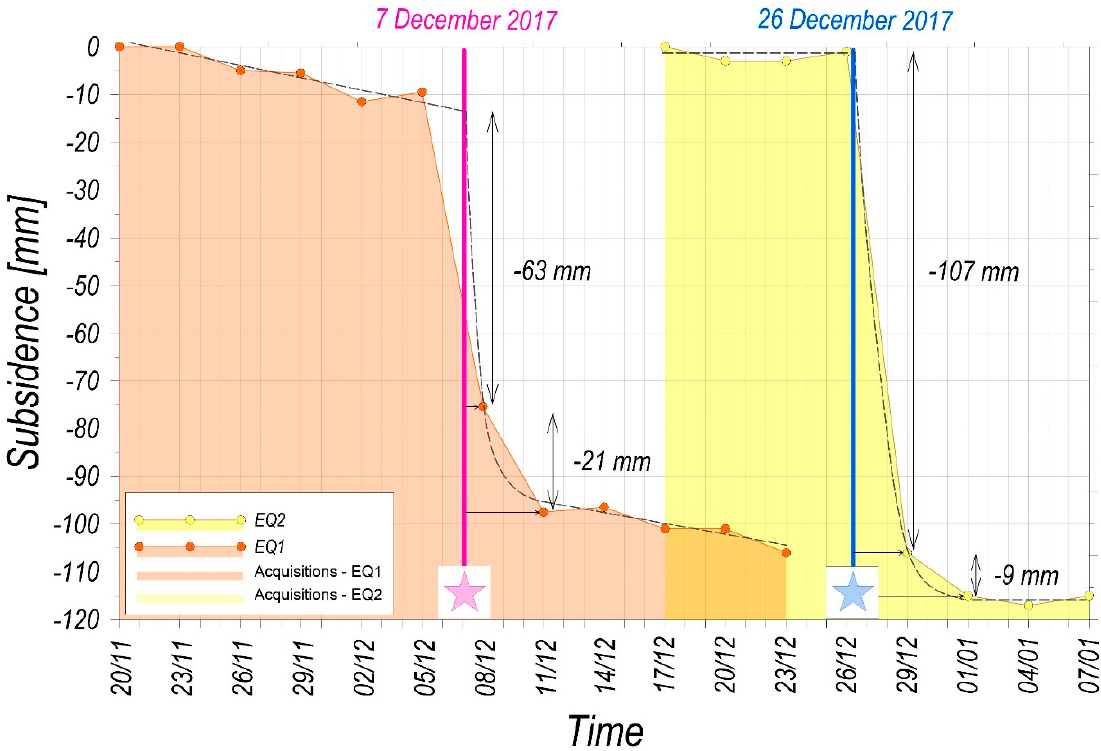
Figure 9. The surface subsidence (vertical displacement) in the epicenters of mining-induced local subsidence troughs in the period between 20th November 2017–7th January